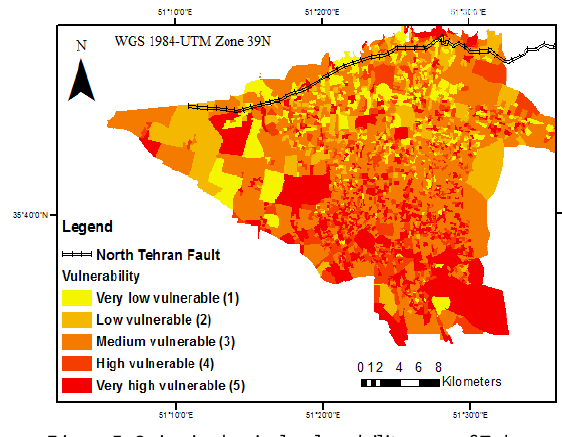
Figure 5. Seismic physical vulnerability map of Tehran considering North Tehran fault activation